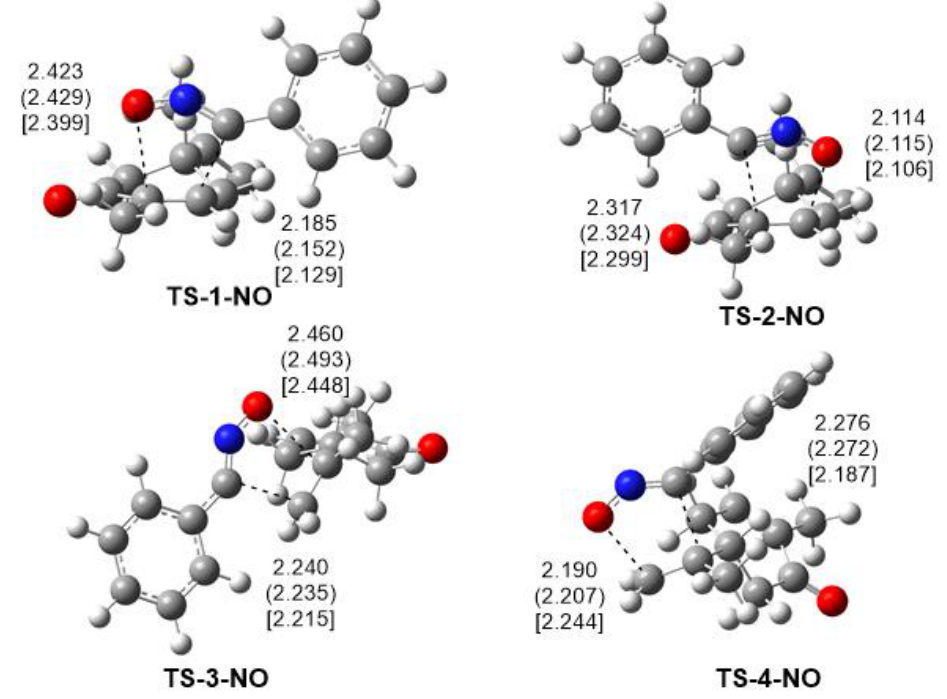
Figure 3. B3LYP/6-31G(d) optimised geometries, in gas phase and in DCM, of the TSs involved in the 32CA reaction of phenyl NO 4a with (R)-carvone 1 . Distances are given in angstroms, Å . Values in DCM are given in parentheses, while the B3LYP/6-311G(d,p) values in DCM are given in